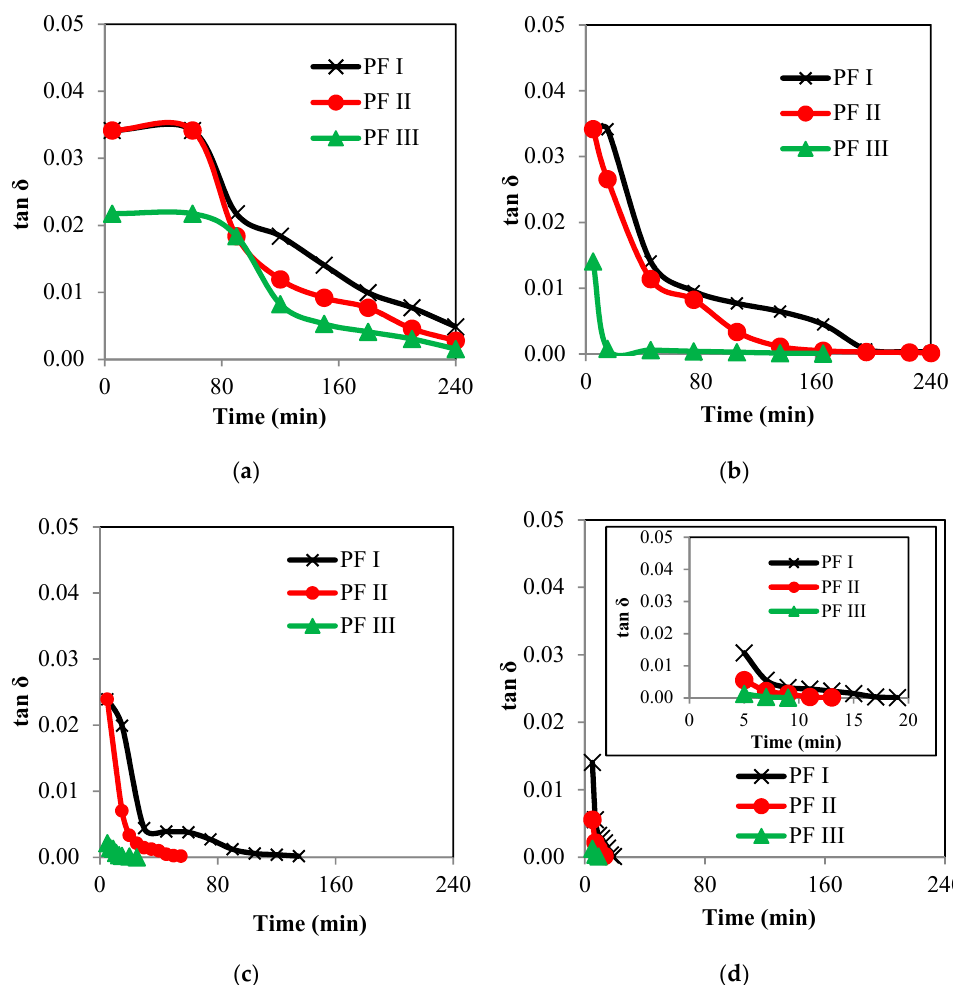
Figure 10. Graphs of tan δ per unit time of phenol formaldehyde samples (PF I, PF II and PF III) synthesized at ( a ) 40; ( b ) 60; ( c ) 80; ( d ) 100 °C.